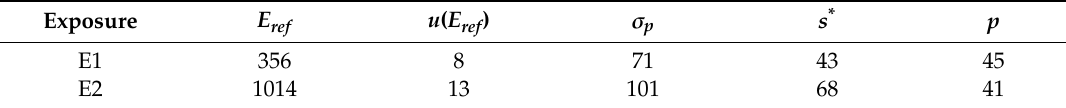
Table 6. Reference parameters of the first exposure E1 and second exposure E2 expressed in kBq m − 3 h obtained from participant results according to ISO 13528:2015. p is the dimensionless number of results.